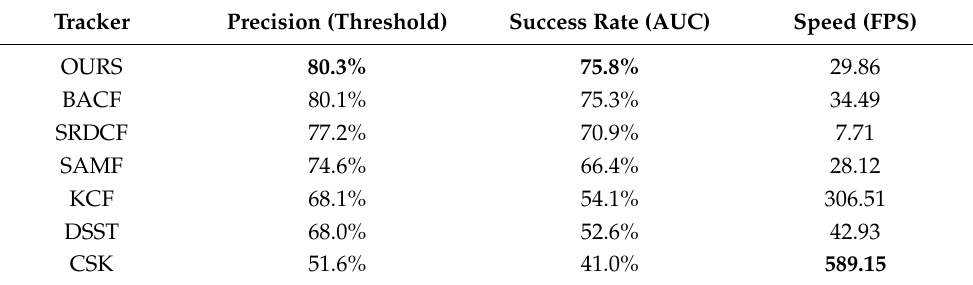
Figure 4. Accuracy and success rate plots of different algorithms tested on the OTB-2015 dataset. Table 1. Average performance of algorithms tested on the OTB-2015